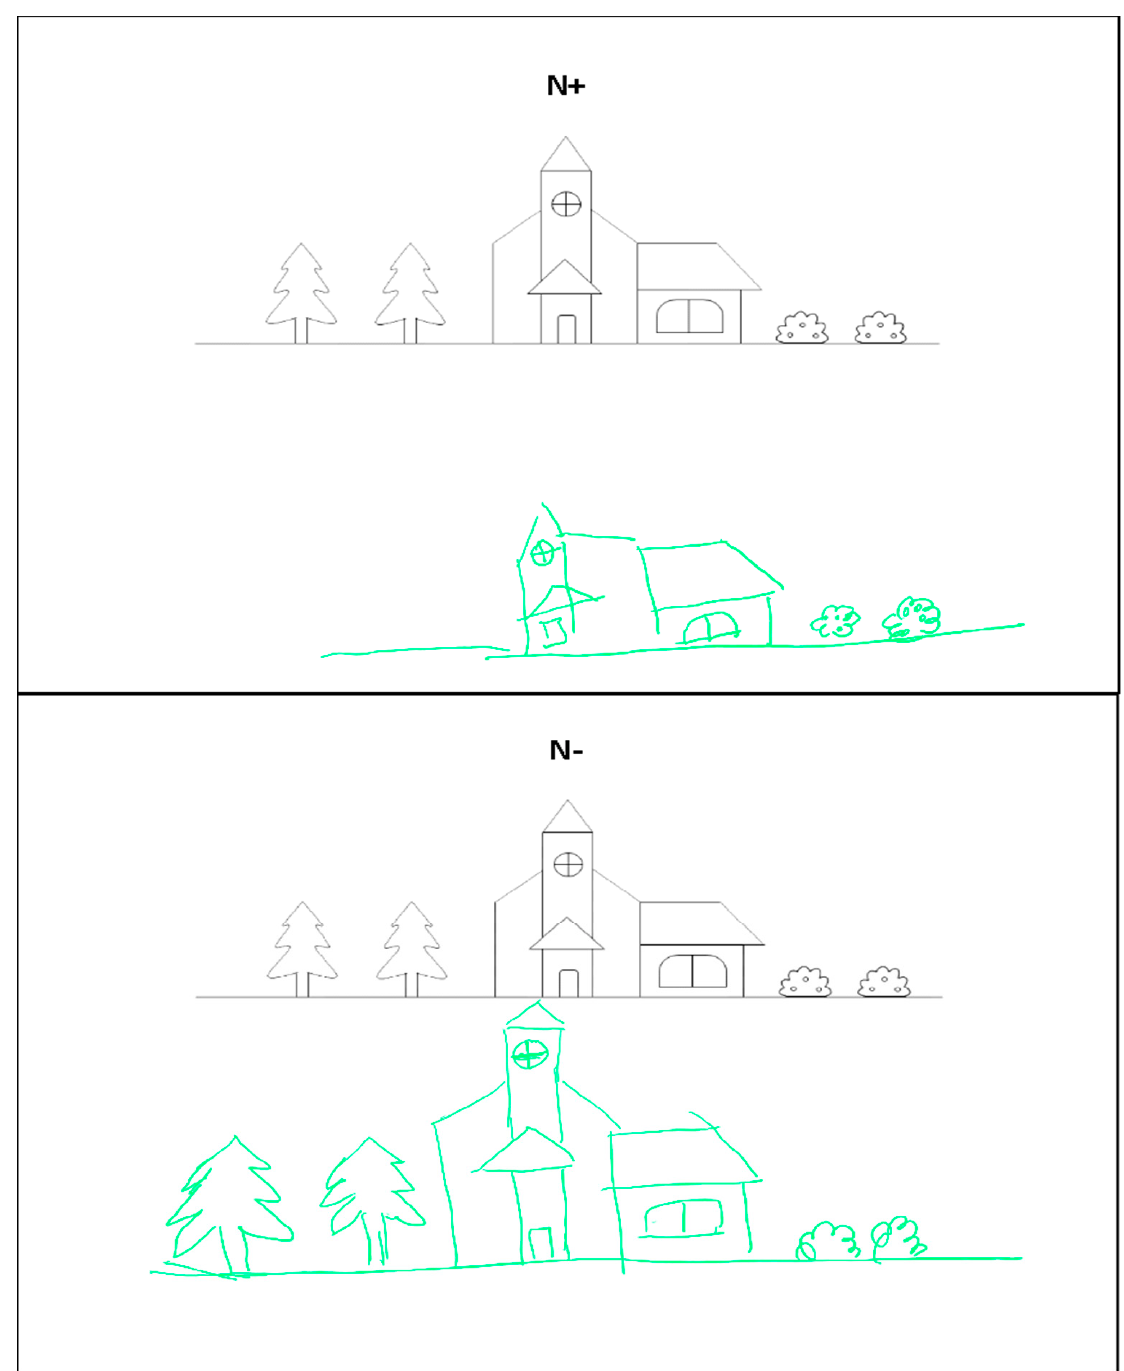
Figure 2. ( A ). Example of N+ (on the top) and N − (on the bottom) patients’ performance at Neu- rit.Space in the Padlocks Cancellation Test. ( B ). Example of N+ (on the top) and N − (on the bottom) patients’ performance at Neurit.Space in the Digital Line Bisection Task. ( C ). Example of N+ (on the top) and N − (on the bottom) patients’ performance at Neurit.Space in the Digital Five Elements Drawing Test. The green lines indicate the patients’ marks in the Cancellation ( A ), Line Bisection ( B ), and Drawing ( C ) tests.